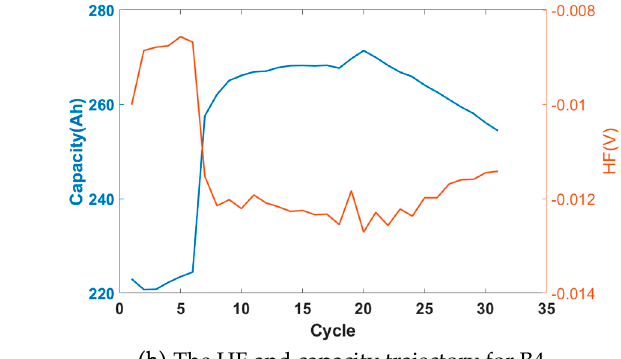
Figure 5. The 3D graph of relevance and HF-capacity trajectory for each battery.